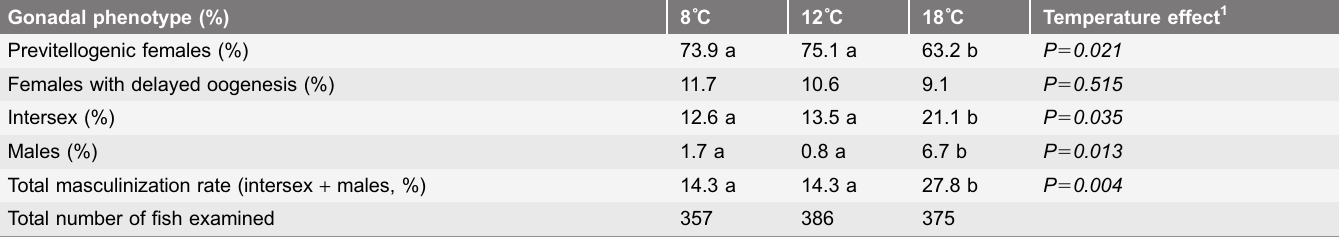
Total number of fish examined 1 : Glimmix analysis performed with for each phenotype the complete set of data (3 temperatures, 4 families) on the logit scale assigning binary gonadal phenotypes (1 5 individual with the target phenotype, 0 5 other individuals) and temperature and family effects modeled as fixed and random effects respectively. Within line: different subscripts (a, b) indicate significant differences among temperatures for the proportion of the gonadal phenotype (paired comparisons of temperature using Glimmix analysis, P , 0.05